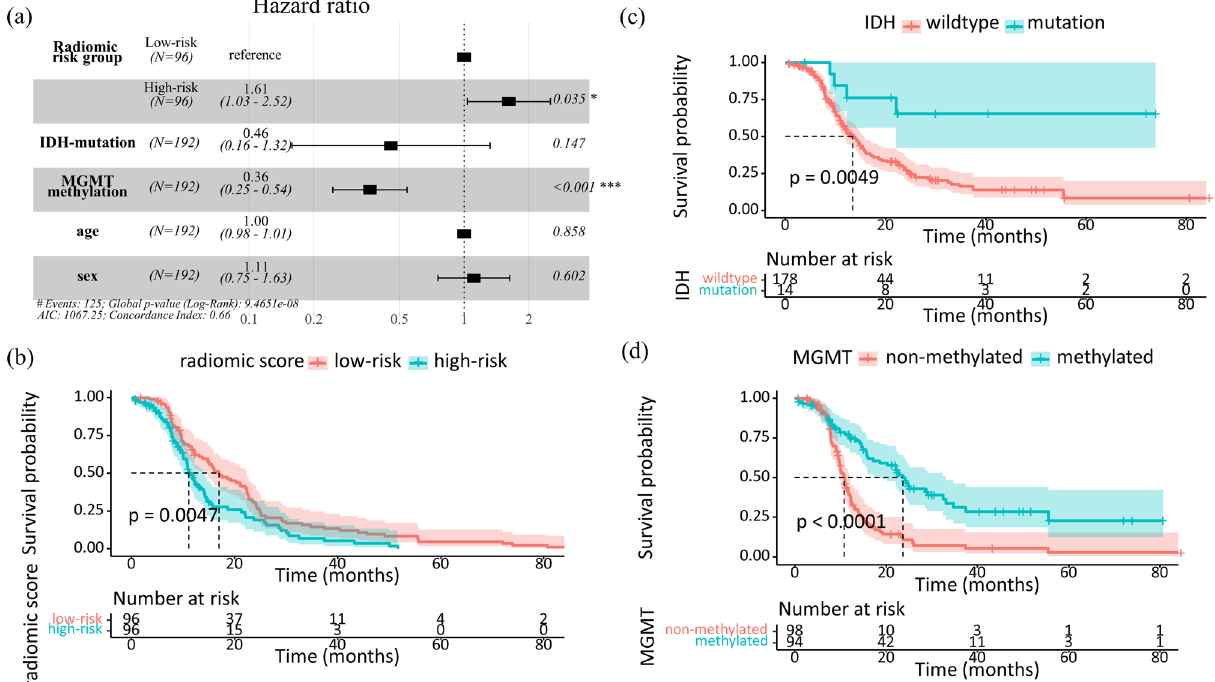
Figure 5. Kaplan–Meier survival curves showing progression free survival (PFS): ( a ) Forest plot of multivariate Cox-regression model; and risk of recurrence was stratified between ( b ) high and low radiomic risk group ( p = 0.0047), ( c ) IDH -mutation and wildtype ( p = 0.0049), and ( d ) MGMT -methylation and unmethylation ( p < 0.0001). Note : p values are obtained from the log-rank test which compares two survival functions according to risk group. 95% confidence intervals of survival functions are indicated as gray zone. Bottom tables indicate the actual number of patients at risk for the survival time according to the risk combined with clinical variables: the radiomic risk variable increased the risk (HR = 1.61, p = 0.035), and MGMT methylation decreased the risk of the recurrence (HR = 0.36, p = 3.52 × 10 –4 ), which is consistent with the previous study 37 . Interestingly, IDH mutation status was not significant ( p = 0.147) when MGMT status variable was in the multivariate Cox regression model, but significant ( p = 0.011) when MGMT status was excepted in the Cox regression, which was similar in the previou study 38 . Recently, sex difference has been revealed to be existent in treatment response of glioblastoma 39 . Smits et al. reported that female sex in combined with MGMT methyla- tion—epigenetic silencing for DNA repair of tumor after temozolomide treatment, which has been shown to be more sensitive to chemotherapy 40,41 —showed more favorable outcome to standard therapy 39,42 . However, in our result, sex was not significant prognostic factor when removing MGMT status from the Cox model or not. Two forest plots for two different multivariate Cox models with and without sex variable are given in Supplementary Fig. 4. Adding and removing variables, radiomic risk group and MGMT methylation were the two only consistent significant prognostic factors in several different multivariate Cox regression models.